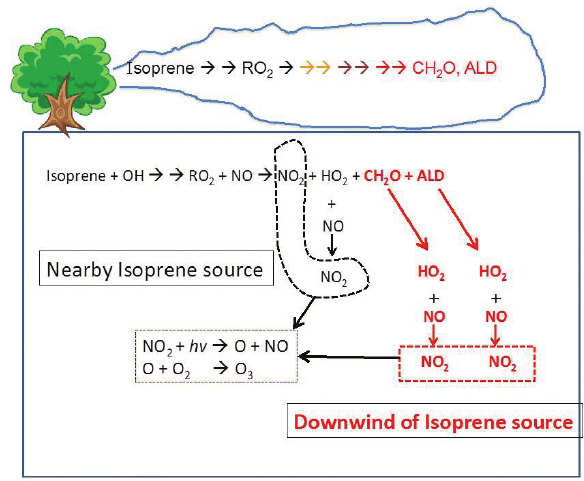
Fig. 7. Schematic picture illustrating the impact of biogenic emis- sions on the photochemical production of ozone in the forest source area and urban areas downwind of the forests.